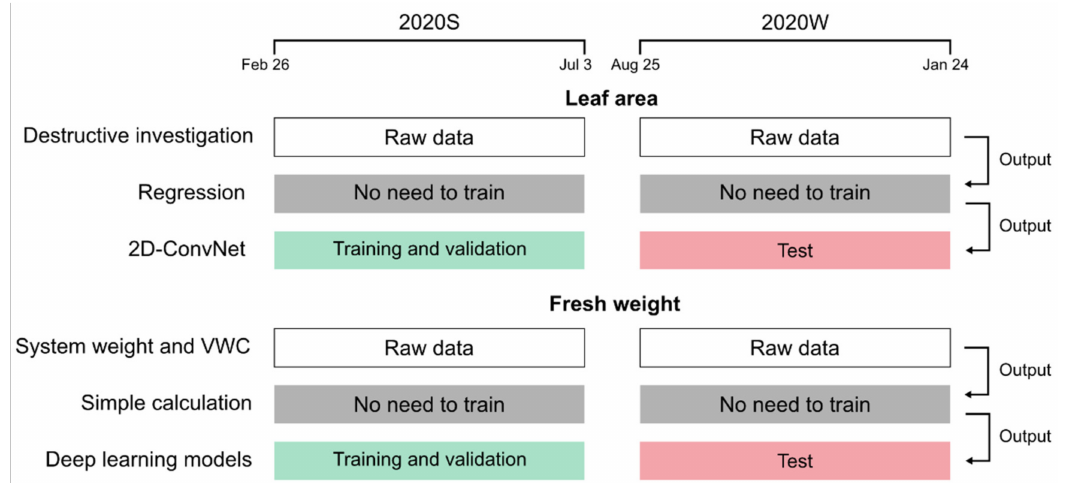
Figure 4. Data division for the model training. Training and validation data were randomly divided at the ratio of 7:3. The total number of data points and images were 363 and 6392, respectively. The regression of leaf area and the calculation of the fresh weight did not require the model training. The regressed leaf area was the output of the 2D ConvNet; and the calculated fresh weight was the output of the deep learning models estimating fresh